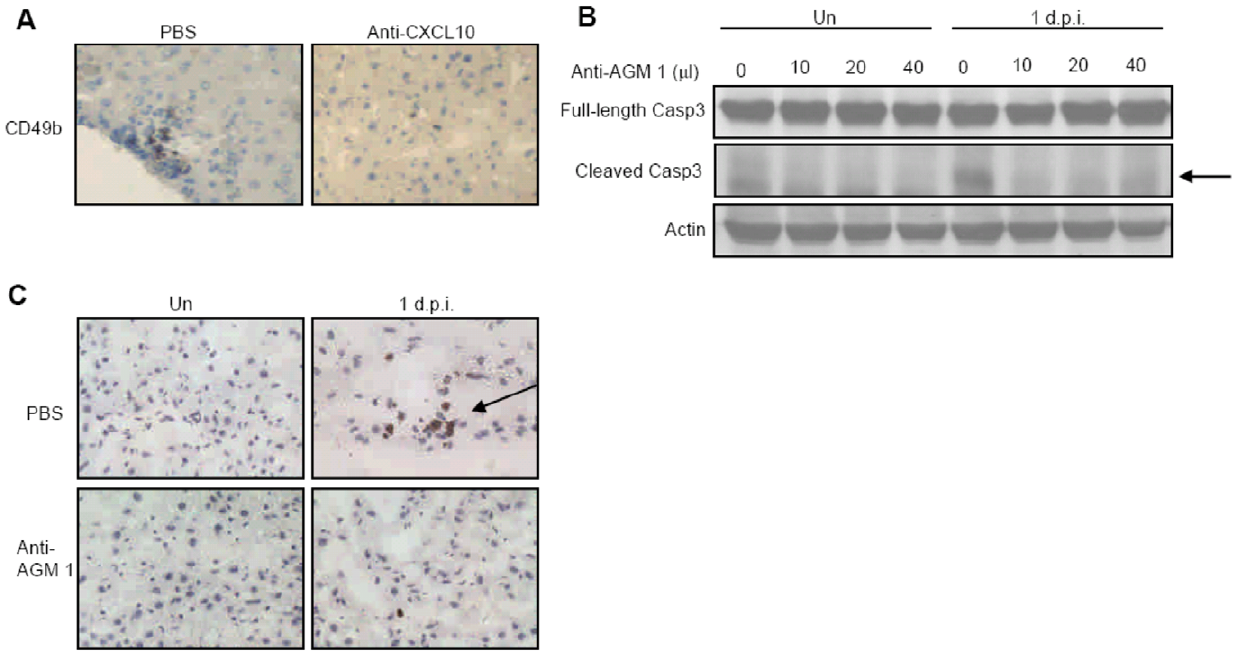
Figure 3. Intrahepatic infiltrating NK cells cause liver cell death at day 1 after DENV infection. (A) Liver cryosections collected from mice with or without anti-CXCL10 antibody at day 1 after DENV infection were stained with anti-CD49b antibody. Data are representative of three independent experiments ( n= 3 per time point in each experiment). (B) Uninfected and infected mice at day 1 were treated with different volumes of anti-AGM1 antibody. Arrow points to cleaved capase 3. Data presented are representative of four independent experiments ( n= 3 per time point in each experiment). (C) Liver cryosections collected from uninfected or infected mice with or without anti-AGM1 were stained with TUNEL reagents. Data are representative of three independent experiments ( n= 3 per time point in each